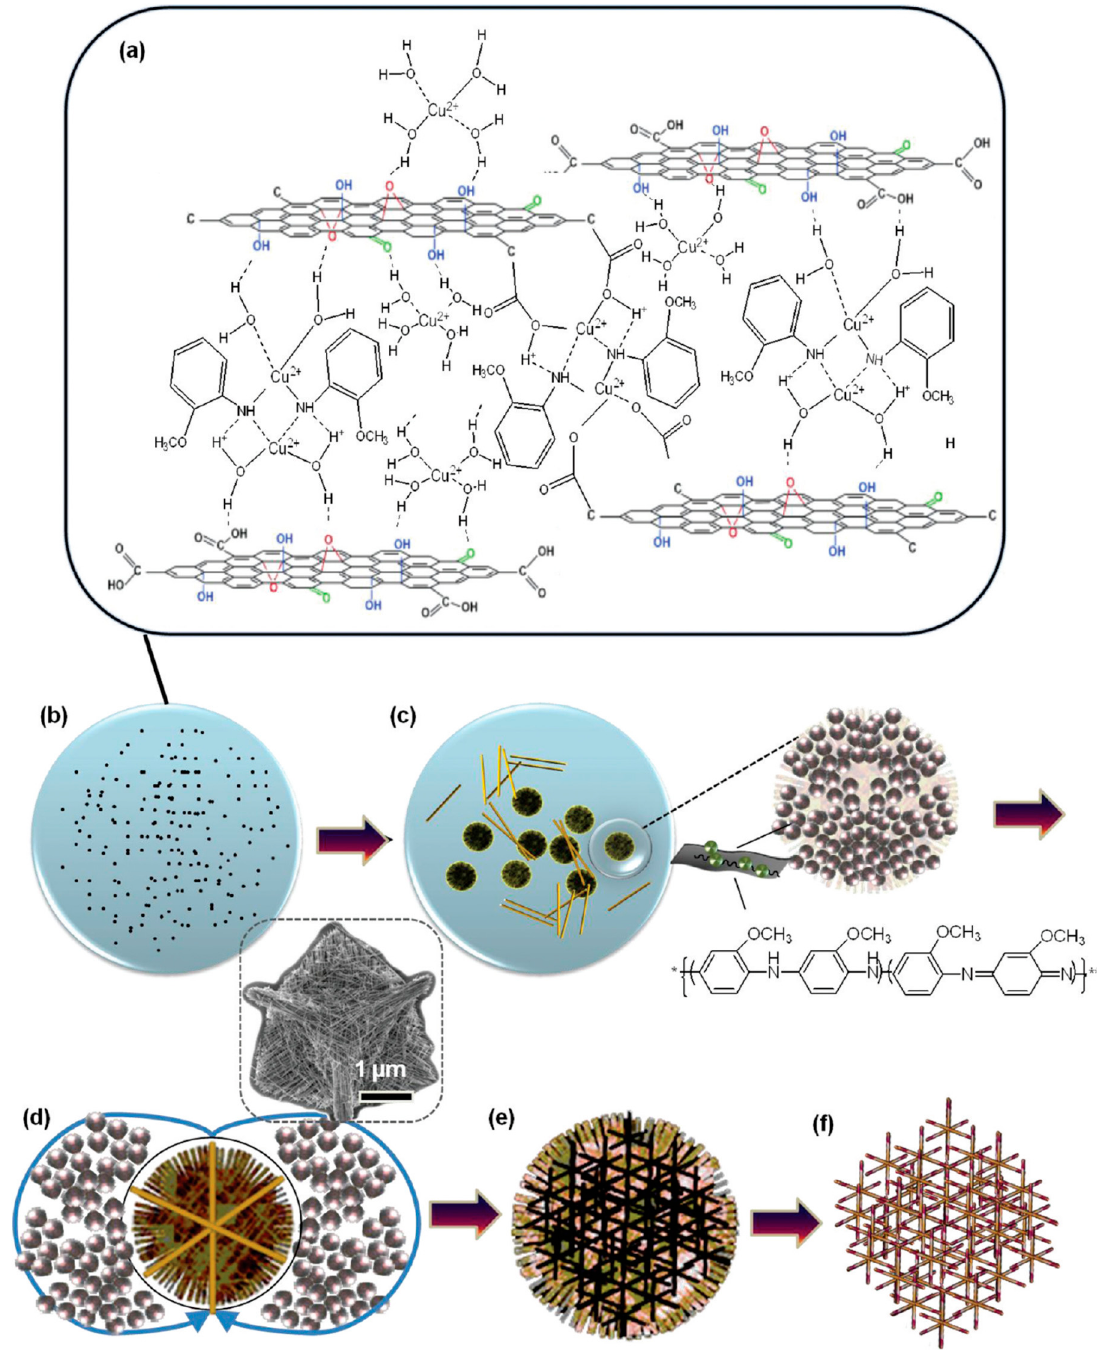
Figure 2. ( a–f ) Schematic illustration of the Cu 2 O crystallization process assisted by o-anisidine and GO. Reproduced with permission from [60], © 2012 American Chemical Society.